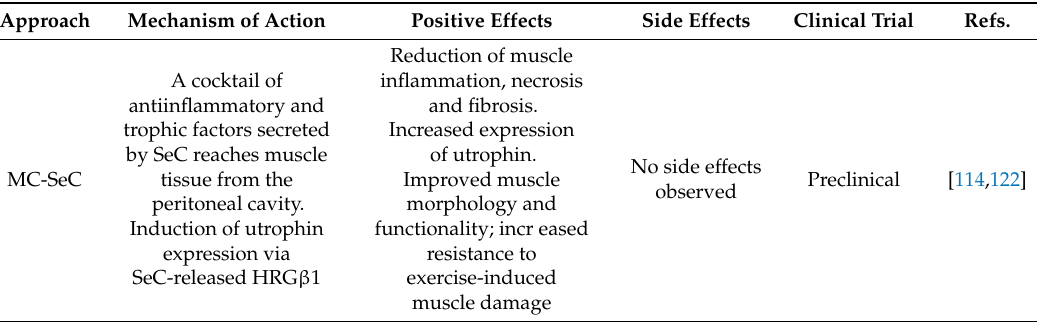
Table 3. Effects of a single i.p. injection of MC-SeC in DMD